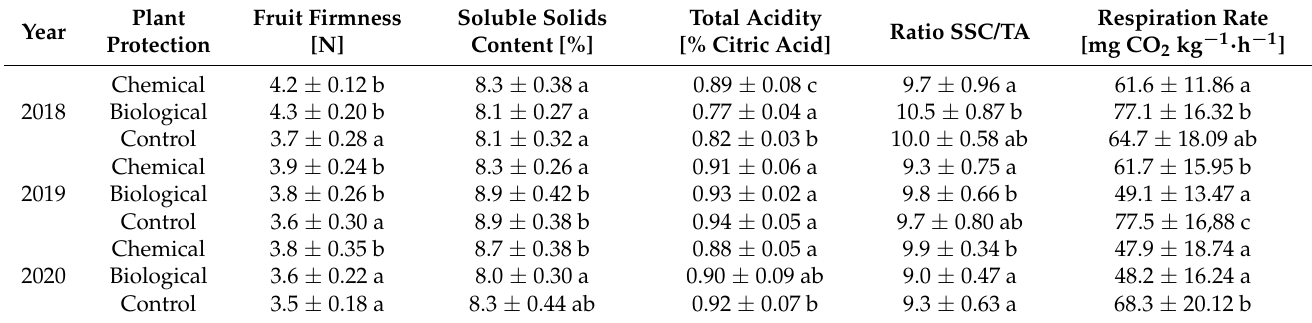
Table 4. Fruit quality of ‘San Andreas’ strawberry directly after harvest, average for harvest dates.